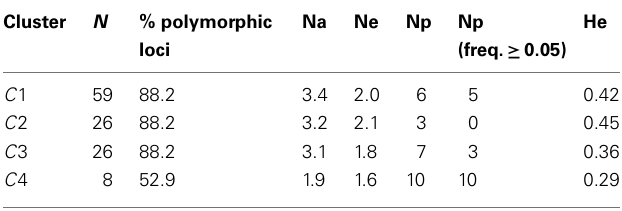
Table 3 | Genetic diversity estimates computed for the 17 cpSSRs considering the four clusters ( C 1, C 2, C 3, and C 4) identified by BAPS analysis.